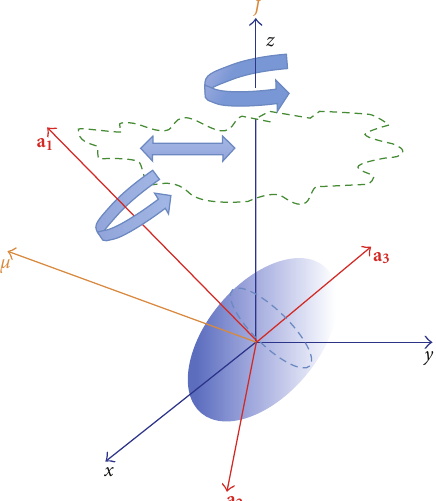
Figure 1: Rotational configuration of a triaxial ellipsoid character- ized by three principal axes: a 1 , a 2 , and a 3 in the inertial coordinate system xyz . Grain angular momentum J is conserved in the absence of external torques and directed along z -axis. The torque-free motion of the triaxial grain comprises the rotation around the axis of major inertia a 1 , the precession of a 1 around J , and the wobbling of a 1 with respect to J . The dipole moment µ , which is fixed to grain body, moves together with the grain and thus radiates electric dipole